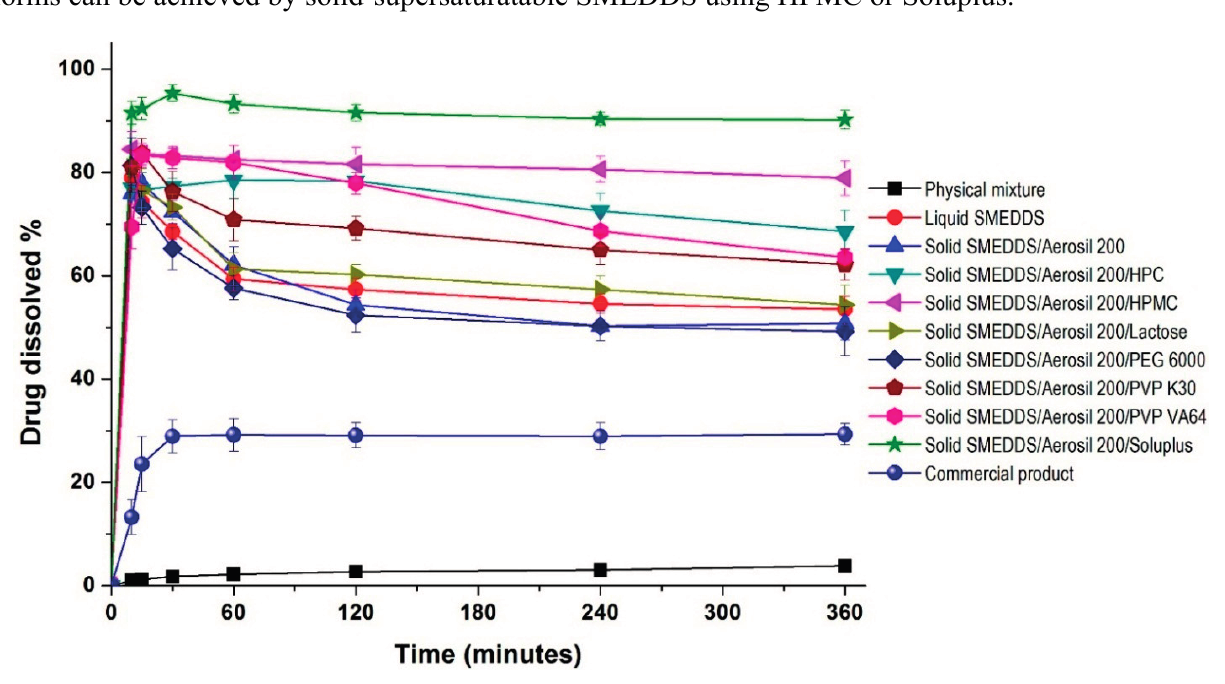
Figure 4. Dissolution profiles of dutasteride-loaded solid-supersaturatable SMEDDS in pH 1.2 dissolution medium. Data are expressed as the mean ± standard deviation ( n = 3).